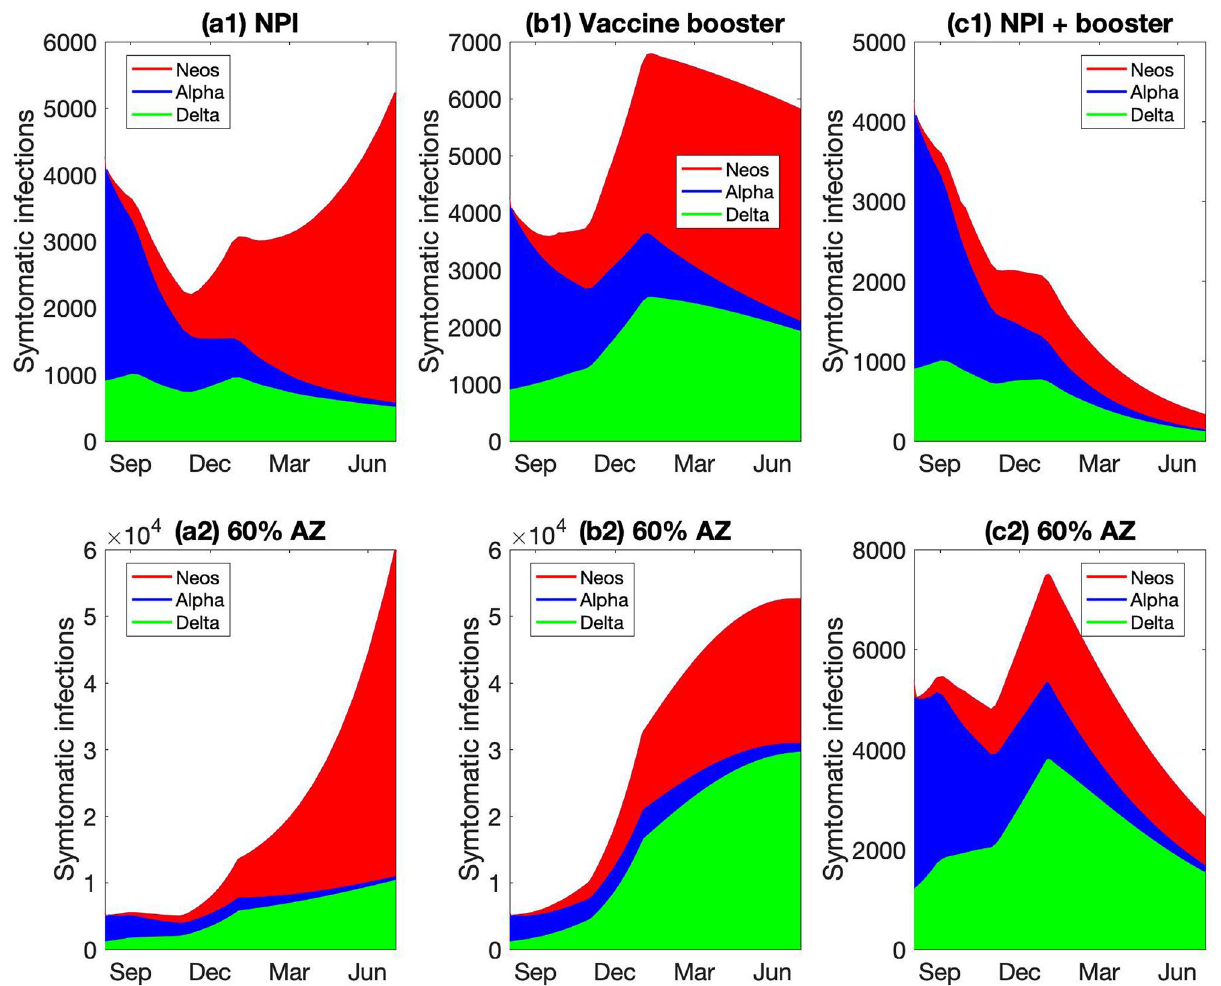
Figure 11. Predicted spread of hypothetical VOC “Neos,” shown from August 1 2021 to June 31 2022. Results are obtained for three scenarios: ( a1 ) more stringent NPI, with mobility decreased further by 40% starting September 1 2021; ( b1 ) a third vaccine booster that offers twice the protection of two doses; ( c1 ) a combination of NPI and vaccine booster. Analogous simulations are then conducted with 60% of the vaccines being AstraZeneca instead of 5% ( a2 ) to ( c2 ). Only by combining pharmaceutical and NPI can the spread of Neos be